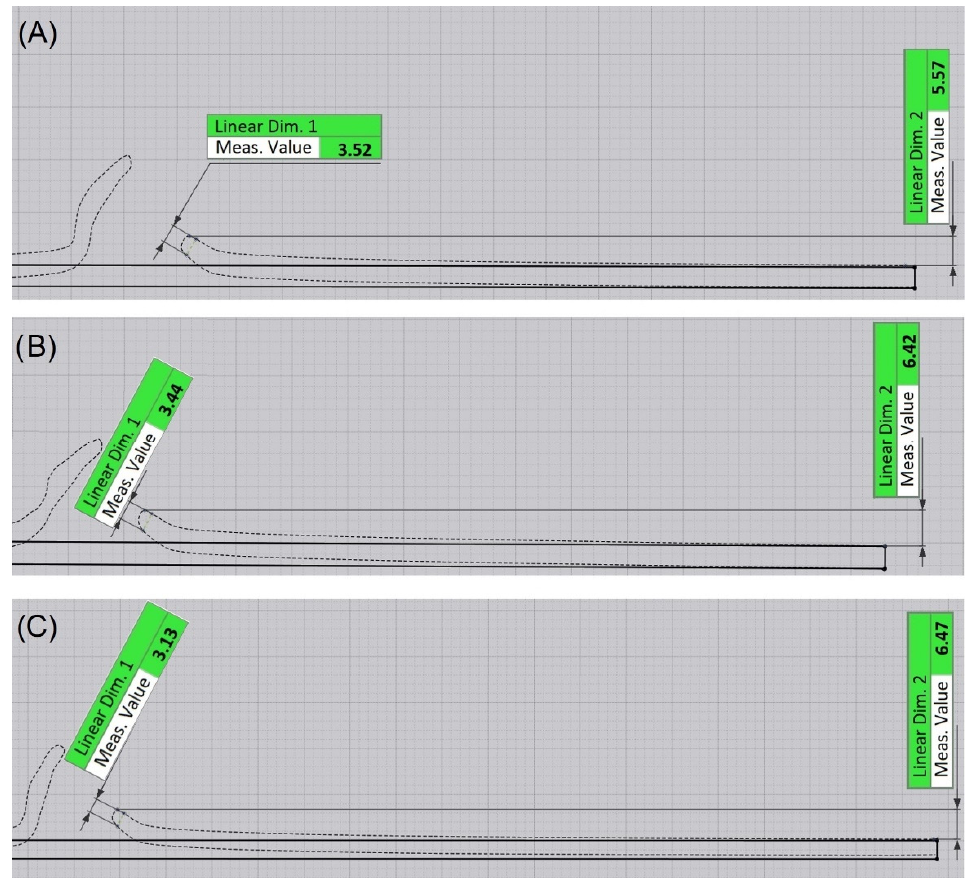
Figure 11. Deflection and reduced thickness of test panels: ( A ) test 6, 300 × 300 mm; ( B ) test 3, 300 × 300 mm; ( C ) test 5, 500 × 500 mm.